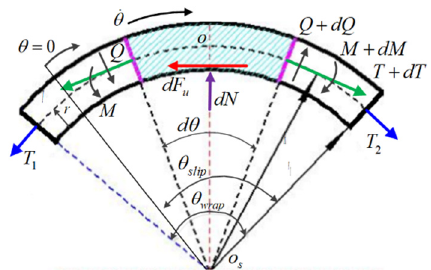
Figure 2. Free-body diagram of a wrapped cable segment.